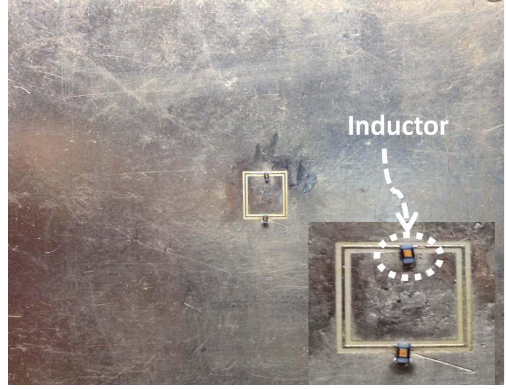
Figure 12. A CSRR after replacing the two narrow conducting bridges with lumped inductors. The red color indicates the highest current magnitude.